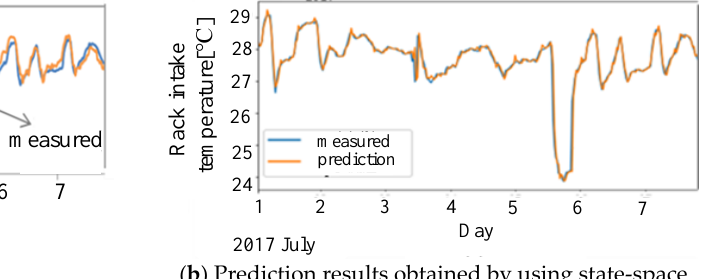
( b ) Prediction results obtained by using state-space model Figure 8. Time-series change of rack intake temperature in rack A7. Figure 8. Time-series change of rack intake temperature in rack Figure 8. Time-series change of rack intake temperature in rack A7.